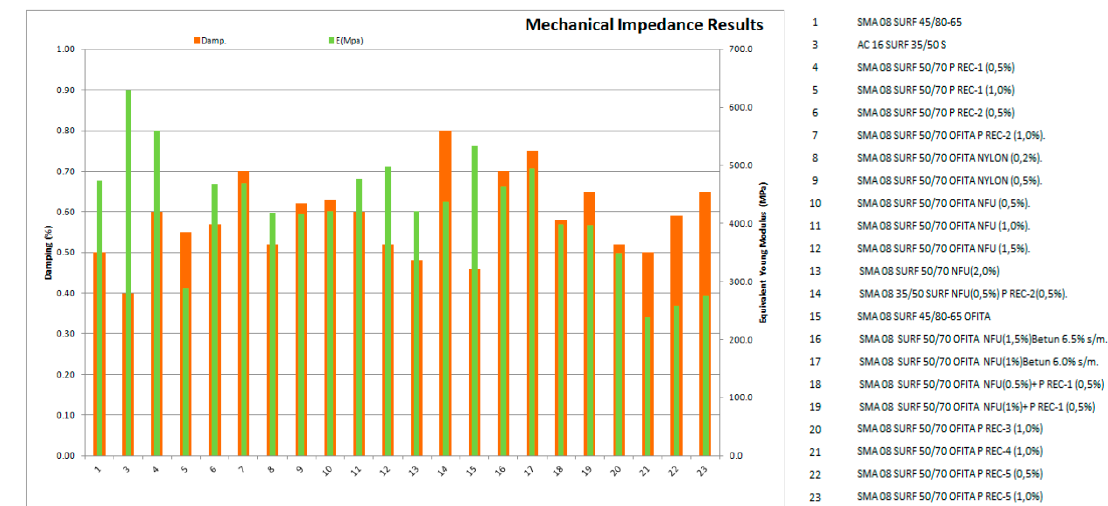
Figure 9. Mechanical impedance results for the 23 different mixtures.